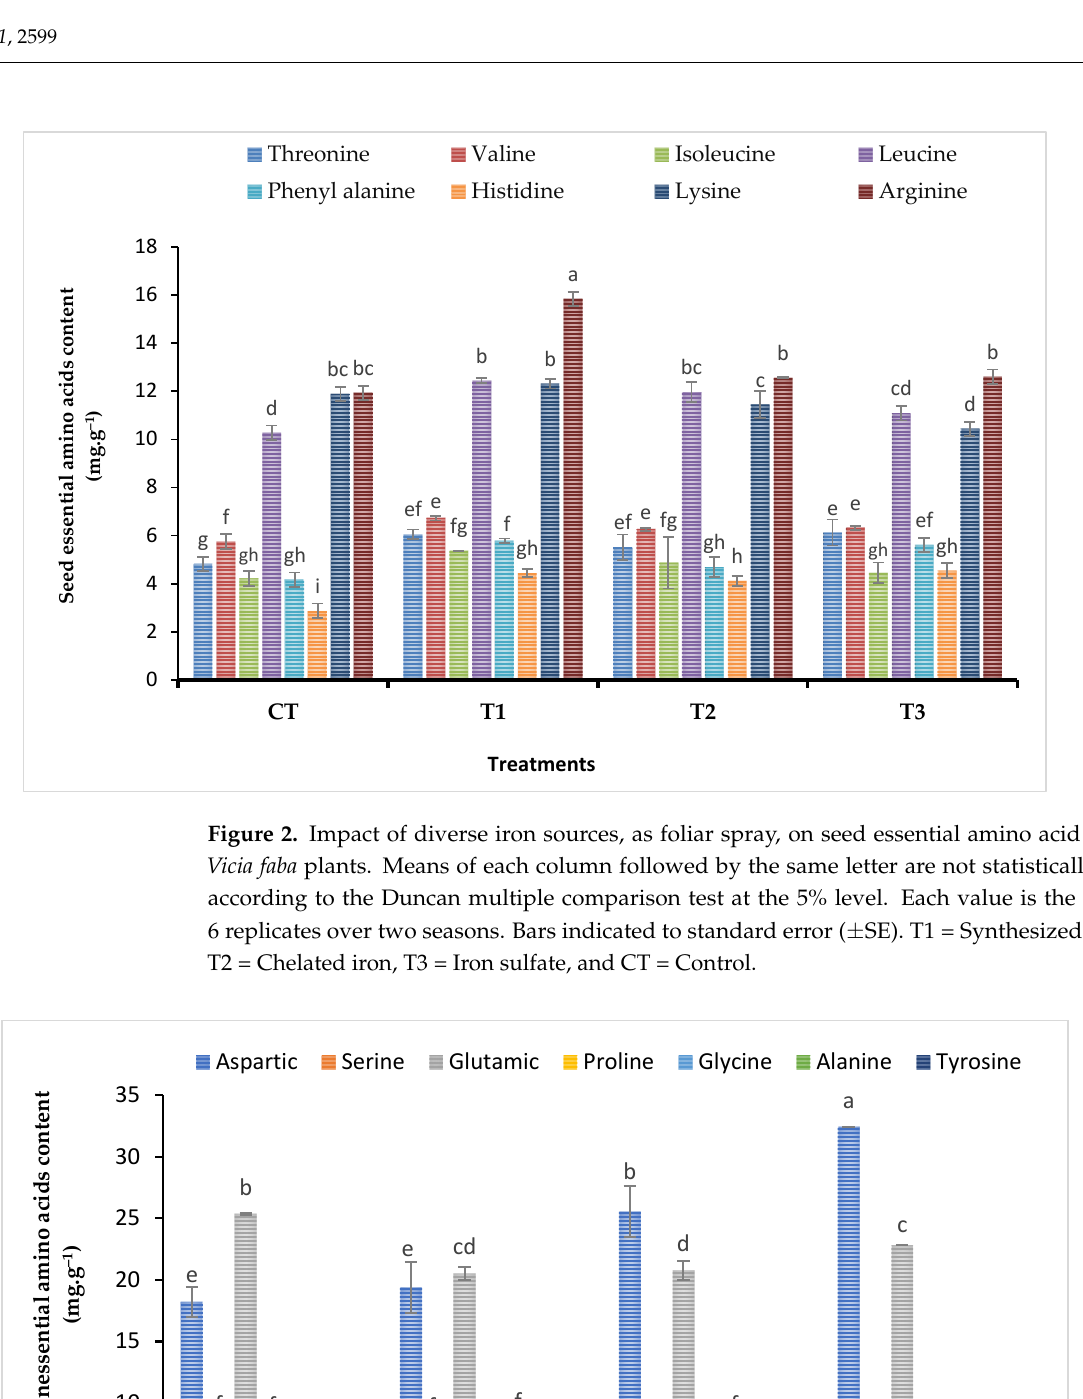
Figure 3. Impact of diverse iron sources, as a foliar spray, on seed nonessential amino acid content of Vicia faba plants. Means of each column followed by the same letter are not statistically different according to the Duncan multiple comparison test at the 5% level. Each value is the average of 6 replicates over two seasons. Bars indicated to standard error (±SE). T1 = Synthesized nano-iron, T2 = Chelated iron, T3 = Iron sulfate, and CT = Control.